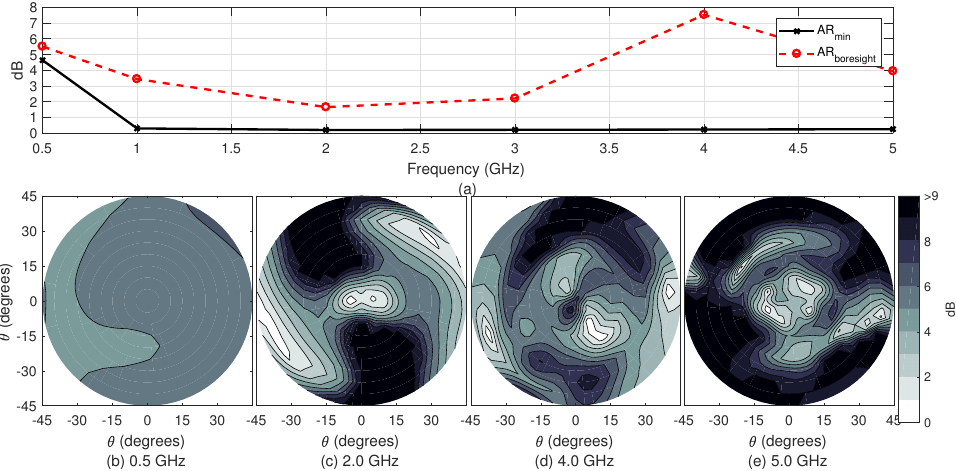
Figure 9. ( a ) Measured axial ratio (AR) at boresight and minimum (within 45 ◦ of boresight) AR versus frequency. Contour plots of the measured AR at: ( b ) 0.5, ( c ) 2.0, ( d ) 4.0 and ( e ) 5.0